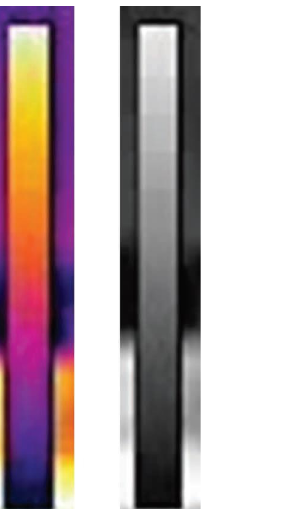
Figure 9: Te heat and temperature ruler representation of a one- frame